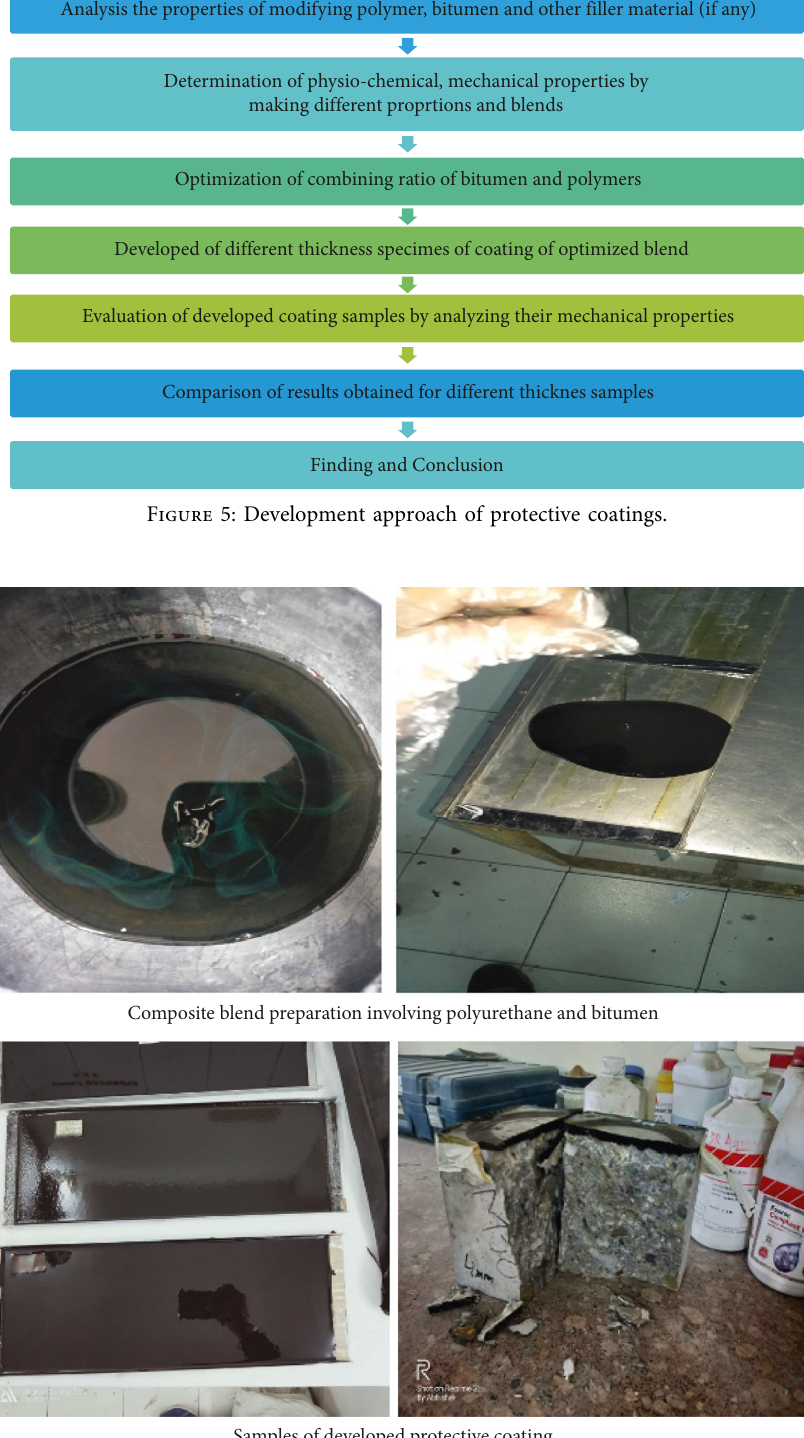
Figure 6: Polymer based protective